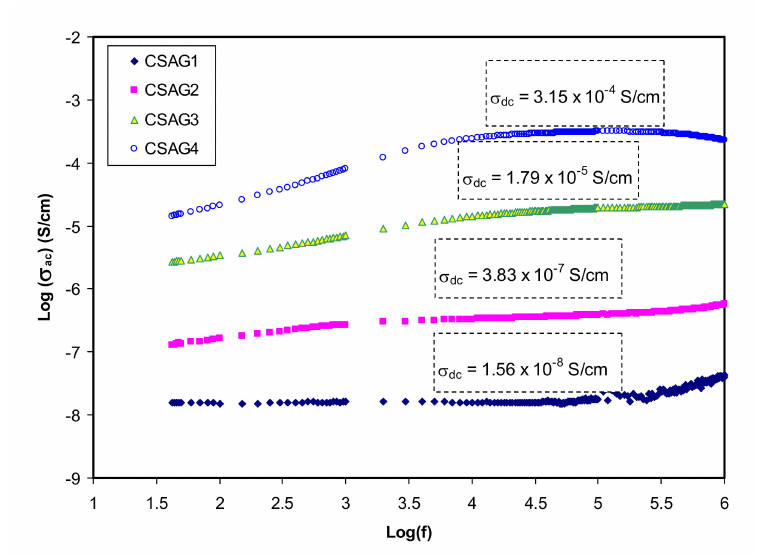
Figure 1. Log-scale of AC conductivity in opposition to frequency for nanocomposite electrolyte membranes at room